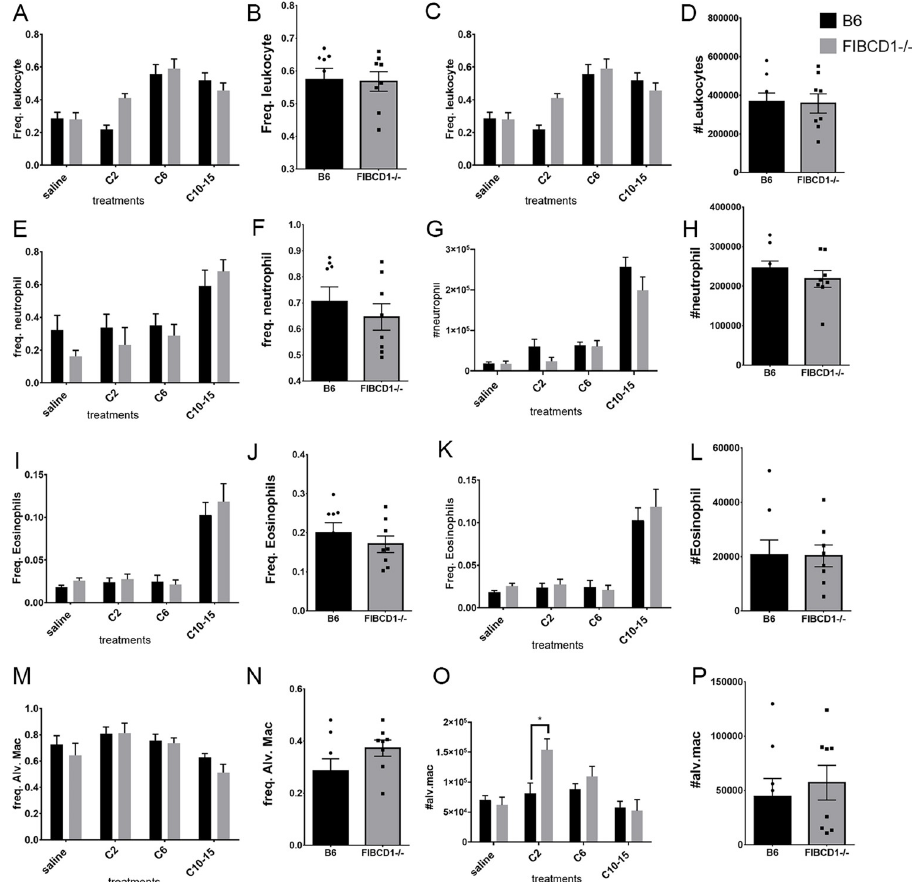
Fig 4. Airway Immune cells recruitment in BALF in response to aspiration of different sizes of purified chitin. Graphical representation depicting gating of BALF CD45+ leukocytes of purified chitin (A, C) and of crude chitin particles (B, D); CD45+ Ly6G- neutrophils of purified chitin (E,G) and of crude chitin particles (F,H); CD45 + Ly6G-SiglecF+CD11c- eosinophils of purified chitin (I, K) and of crude chitin particles (J,L); CD45+ Ly6G-SiglecF +CD11c+ alveolar macrophages of purified chitin (M, O) and of crude chitin particles (N,P). Data are a summary of 2 experiments. n = 8/group. � p < 0.05, �� p < 0.01, ��� p < 0.001, ���� p < 0.0001.